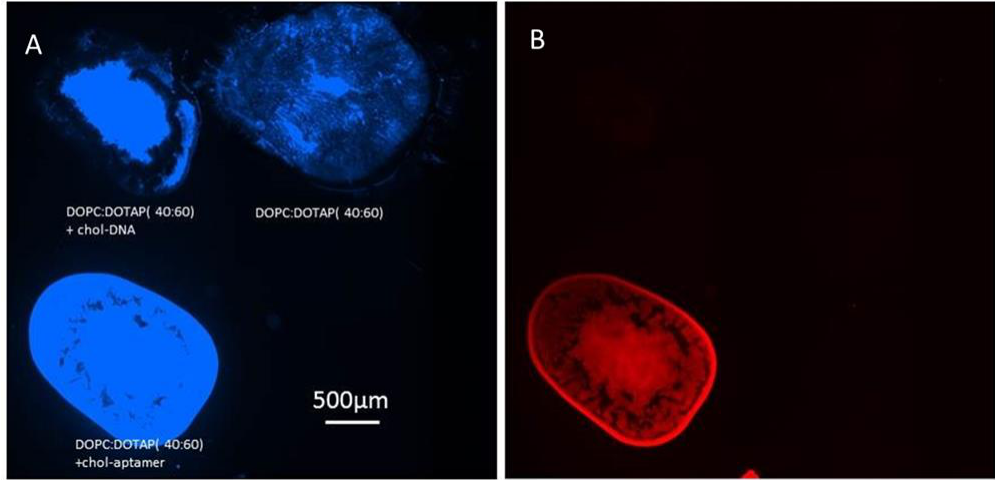
Figure 4. Control experiment to test if the binding to the DOPC:DOTAP 40:60 formulation was due to the aptamer or to electrostatic interactions. ( A ) Blue fluorescent image of an array of micrometer-thick multilayer spots composed of three different lipid compositions, DOPC:DOTAP 40:60 with a non-aptamer control DNA sequence, DOPC:DOTAP alone, and DOPC:DOTAP 40:60 with the aptamer sequence. The lipids were labeled blue. Panel ( B ) shows a fluorescence micrograph of the same array after exposure to fluorescently labeled thrombin, showing analyte binding only to the aptamer functionalized lipids.